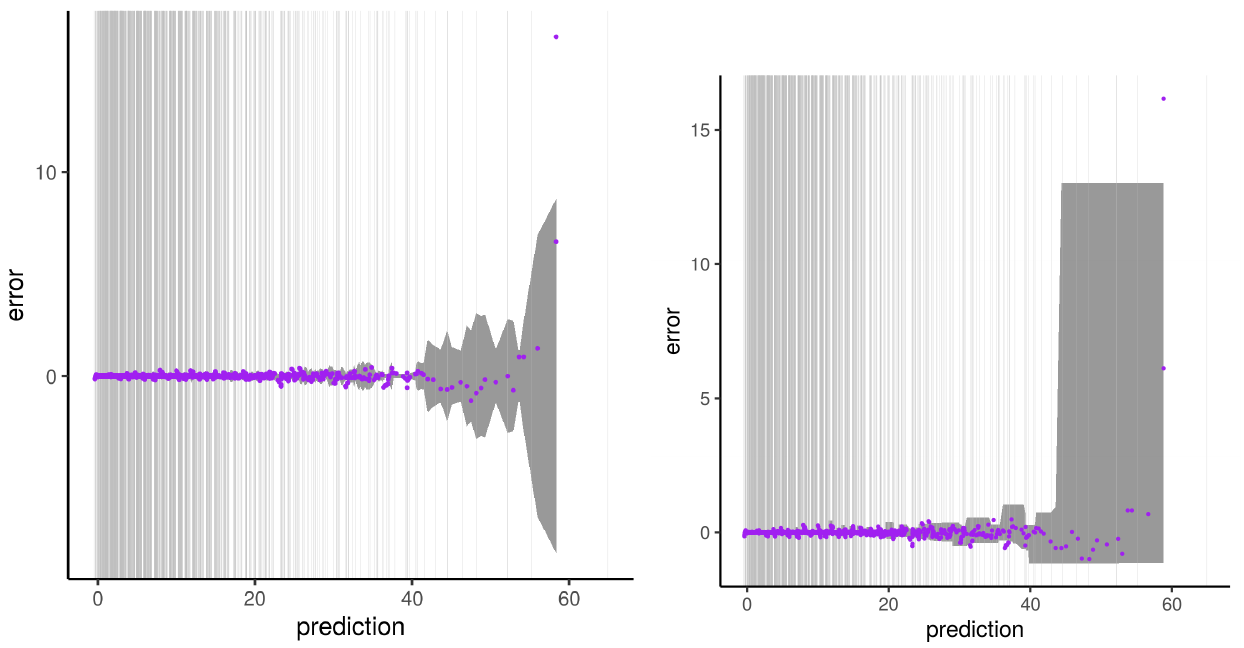
Figure 15. Same as Figure 12 for the fourth run of the